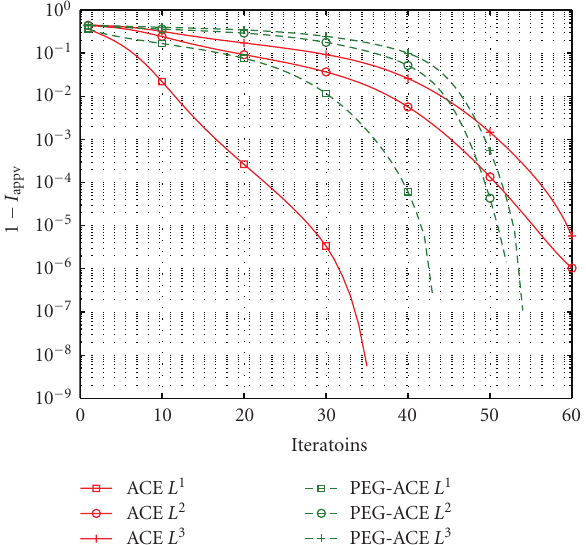
Figure 8: Distance of variable node a posteriori MI to the maximum MI as a function of the number of decoder iterations at E b /N 0 = 0 . 7dB.